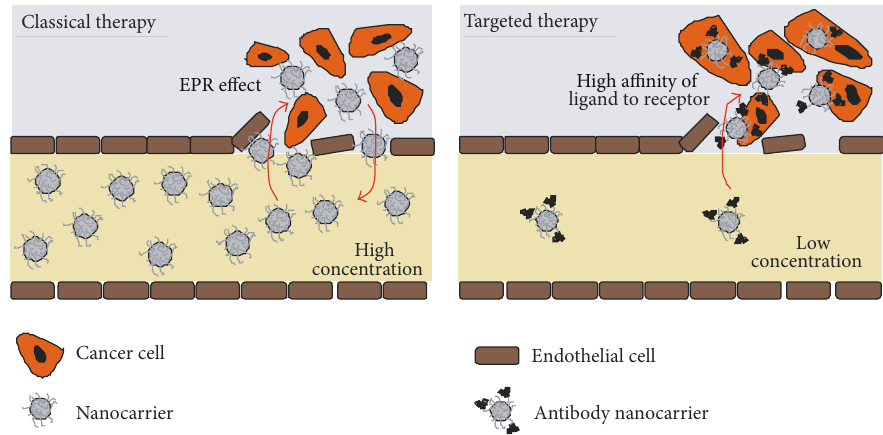
Figure 1: The mechanism of drug delivery in classical and targeted therapy (the figure is based on [12,